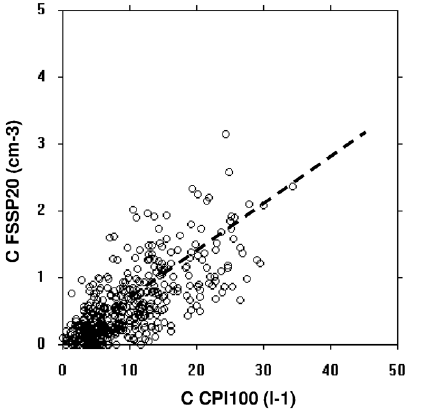
Fig. 9. Number concentration of ice crystals ( d > 20µm) mea- sured by the FSSP-100 versus the concentration of ice particles ( d > 100µm) measured with the CPI (ASTAR, 8 April 2007).